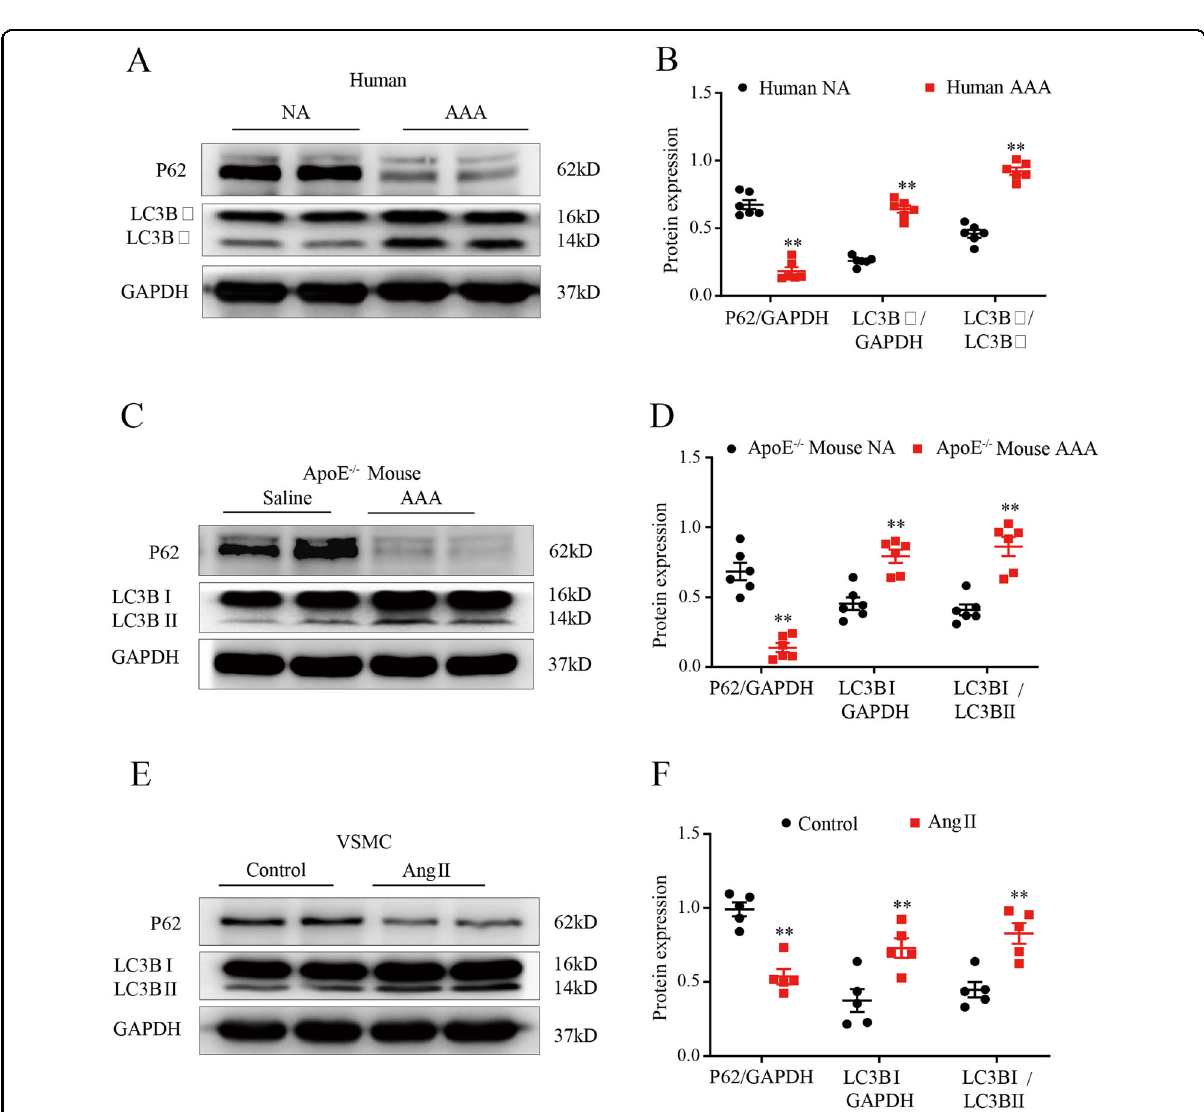
Fig. 6 Autophagy is activated during AAA formation. A and B WBs and densitometric analysis of the protein levels of P62 and LC3 β in human AAA samples and adjacent nonaneurysmal aortic sections ( n = 6). NA indicates nonaneurysmal aorta. C and D WBs and densitometric analysis of the protein levels of P62 and LC3 β in AAs from Ang II-induced ApoE − / − mice and control ApoE − / − mice (male; n = 6). Saline indicates control male ApoE − / − mice. E and F WBs and densitometric analysis of the protein levels of P62 and LC3 β in VSMCs treated with Ang II for 24 h (1 μ mol/L; n = 6). Control indicates VSMCs treated with PBS. Data are presented as the mean ± SE. * p < 0.05, ** p <